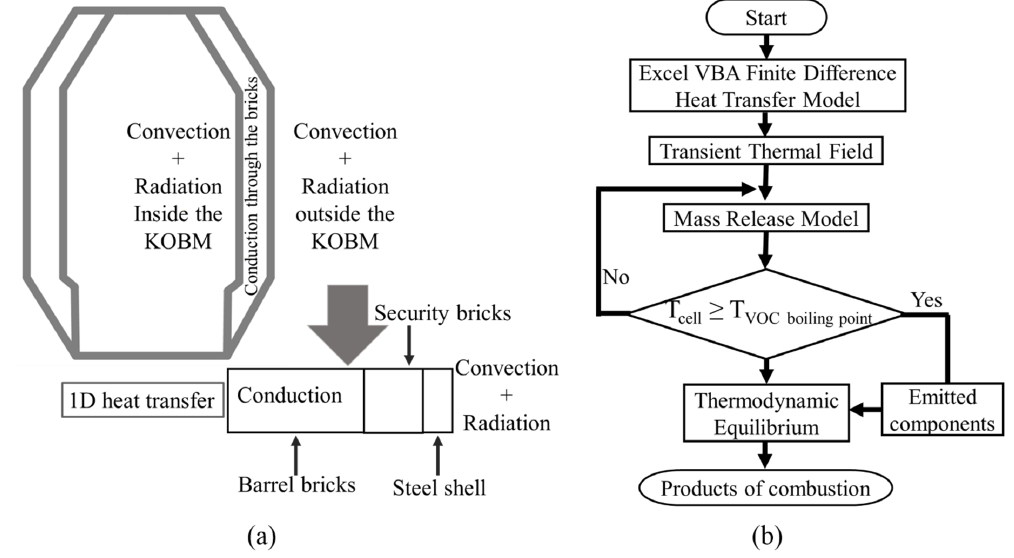
Figure 2. Modeling schemes for: ( a ) heat transfer, ( b ) mass Figure 2 . Modeling schemes for: ( a ) heat transfer, ( b ) mass transfer.